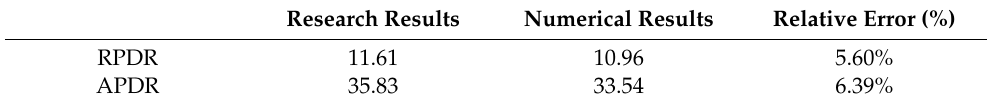
Table 1. Comparison of research results.